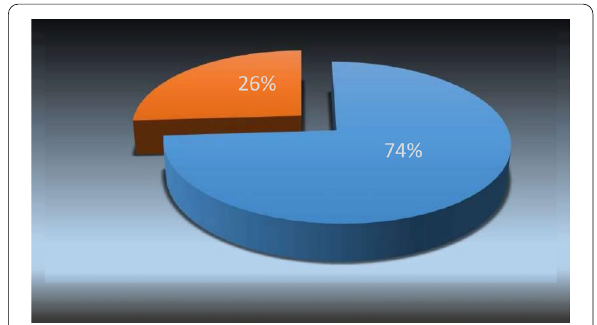
Fig. 2 Pie chart showing distribution of women according to outcome of labour induction